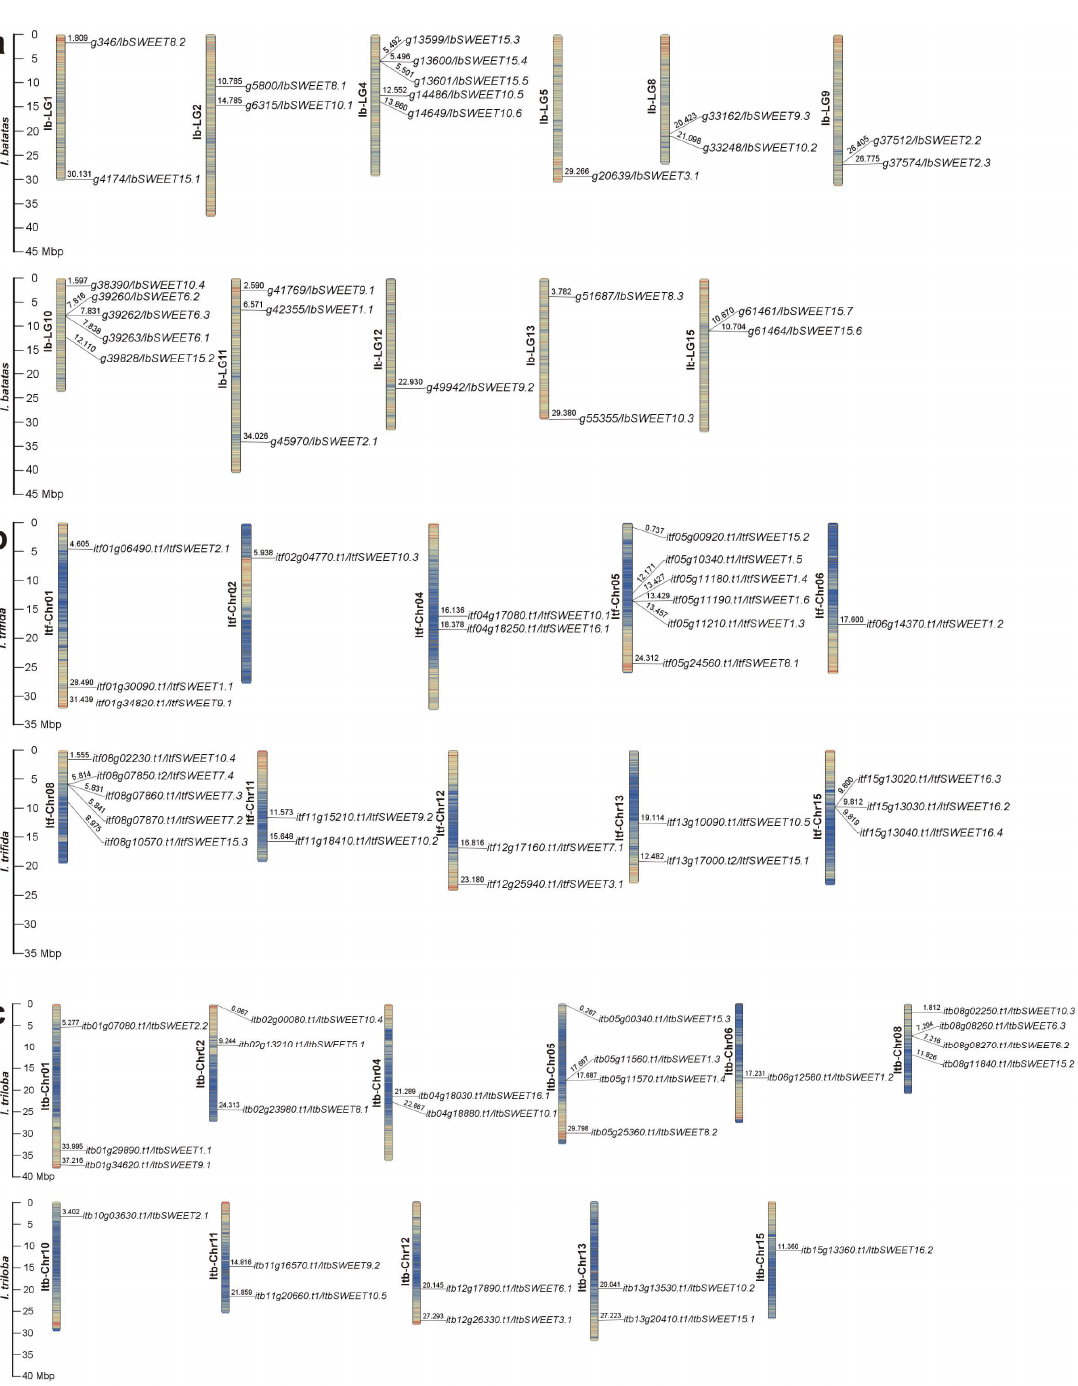
Figure 2. Chromosomal localization and distribution of SWEETs in I. batatas ( a ), I. trifida ( b ), and I. triloba ( c ). The bars represent chromosomes. The chromosome numbers are displayed on the left side, and the gene names are displayed on the right side. Each gene location is shown on the line. Detailed chromosomal location information is listed in Table S1.